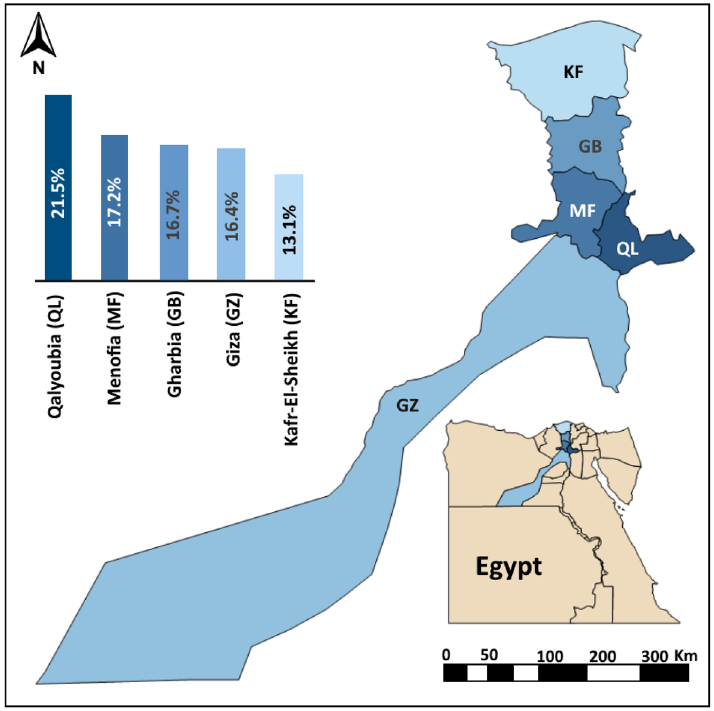
Figure 1. Distribution of West Nile virus infection (WNV) in horses of the Nile Delta of Egypt. The column graph showed the seroprevalence of WNV infection for each